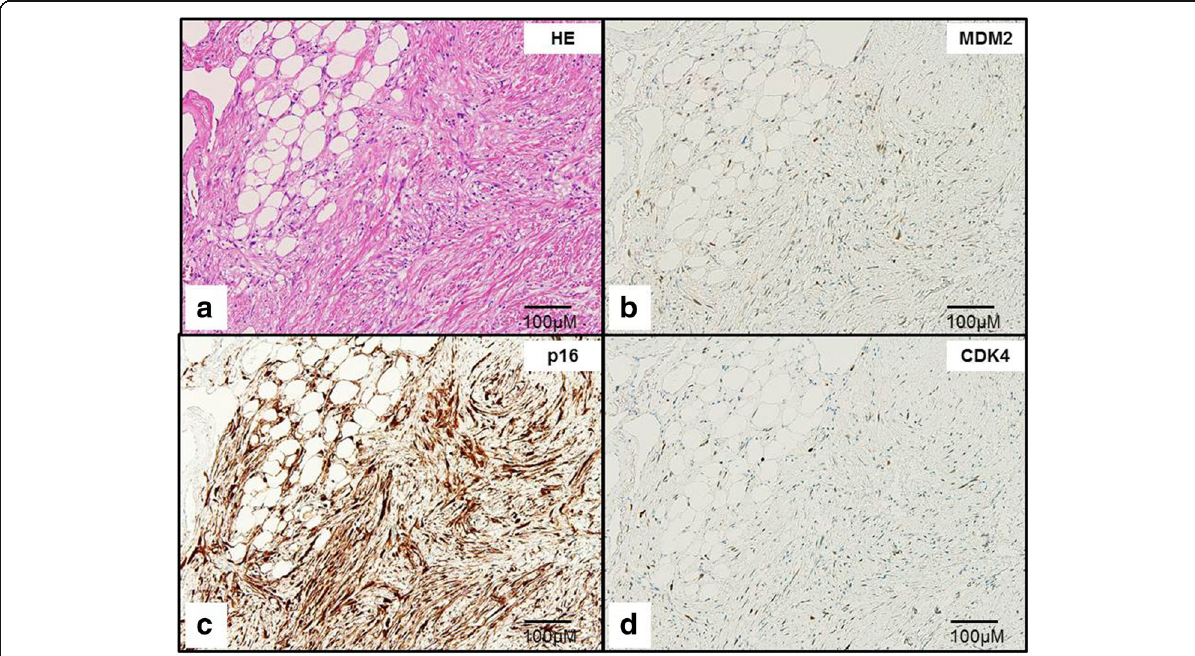
Fig. 3 Immunohistochemistry for p16, CDK4, and MDM2 expression. ( a ) Hematoxylin eosin stain. Immunohistochemistry of ( b ) MDM2, ( c ) p16, and ( d )